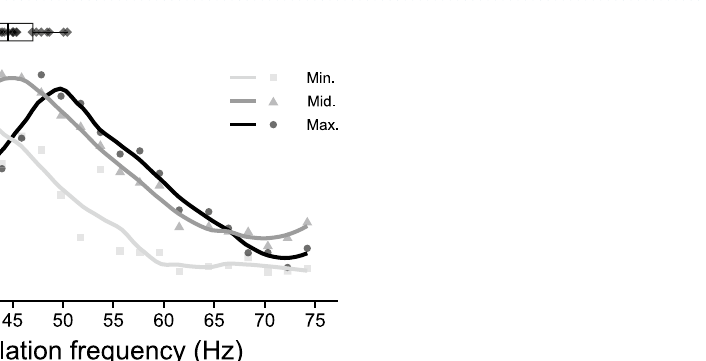
Figure 7. The TMTF ASSR within the 0.5–20 Hz region obtained during the test and retest sessions (N = 10). Each panel show the individual phase-locked activity averaged across the left and right hemispheric channel for the test (orange) and retest (blue) session, and the neural background noise for the test (red) and retest (black) session. The retest data of S14 was only available for 0.5–10 Hz. The data show that the TMTF ASSR was robust across sessions, indicating that these phase-locked activity patterns are inherent to each subject.